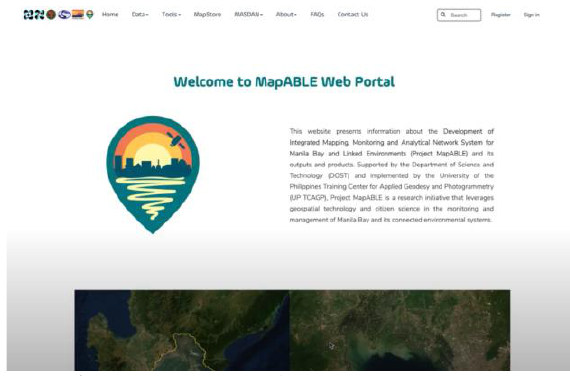
Figure 3. Home page of the MapABLE Web Portal.